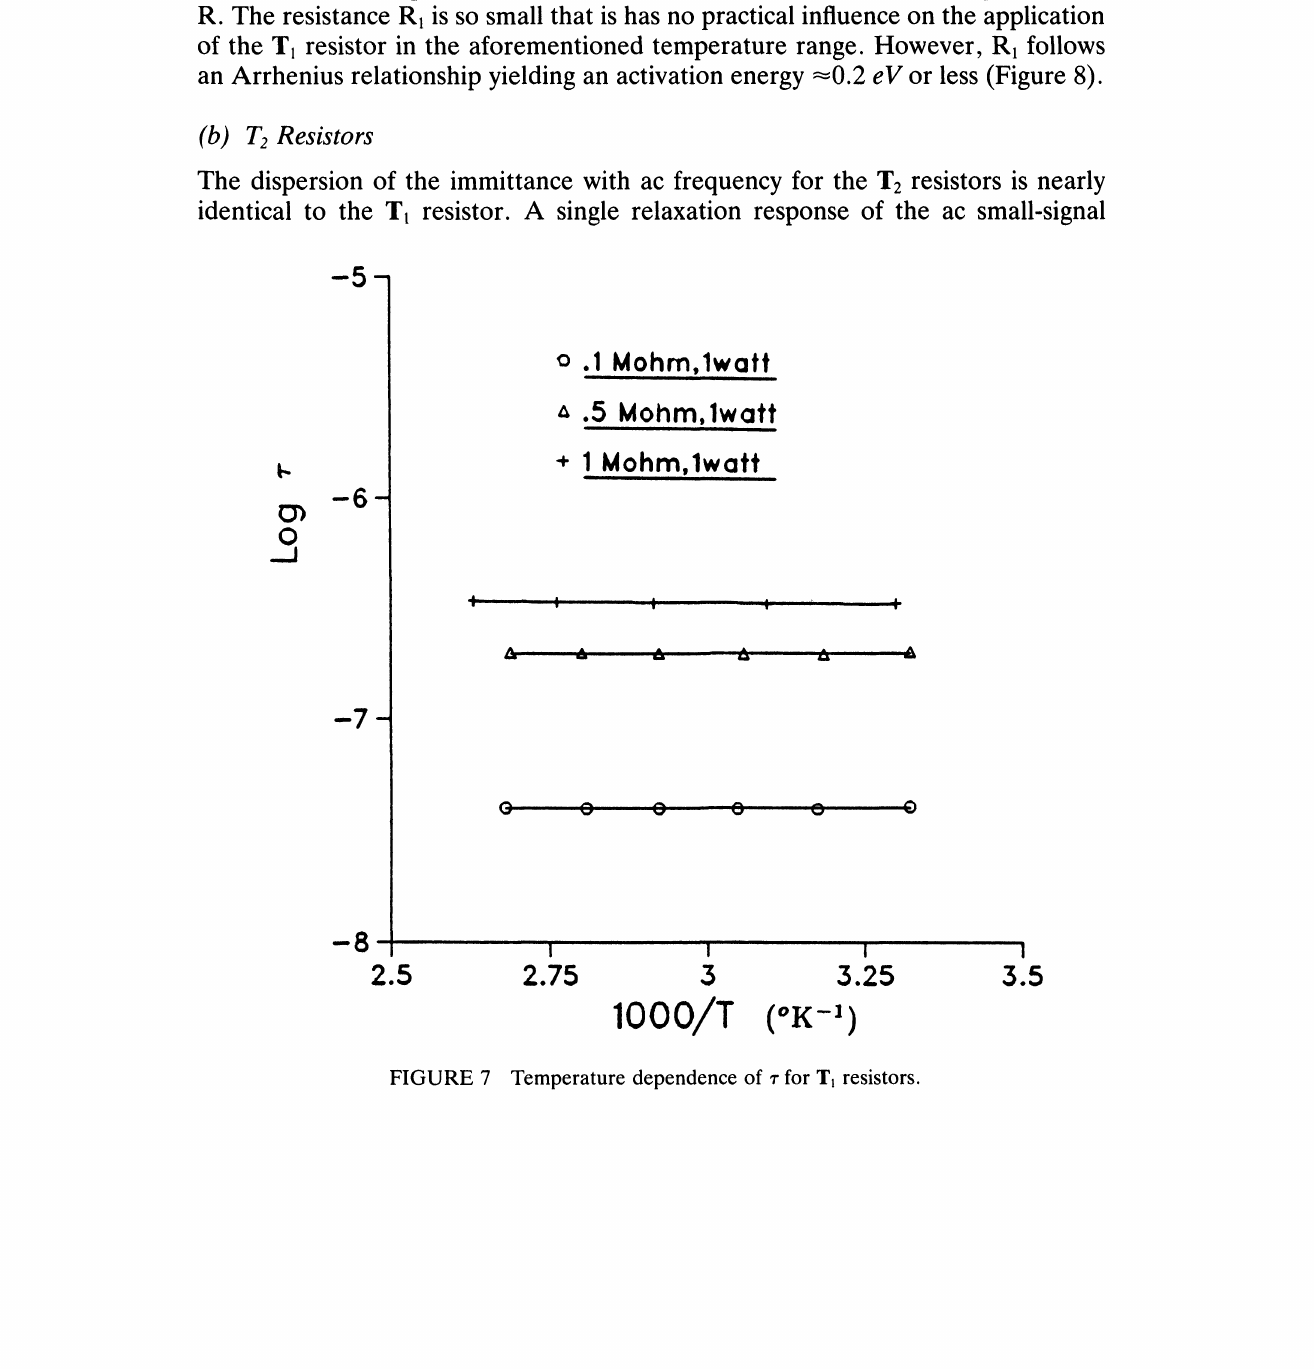
FIGURE 7 Temperature dependence of z for T